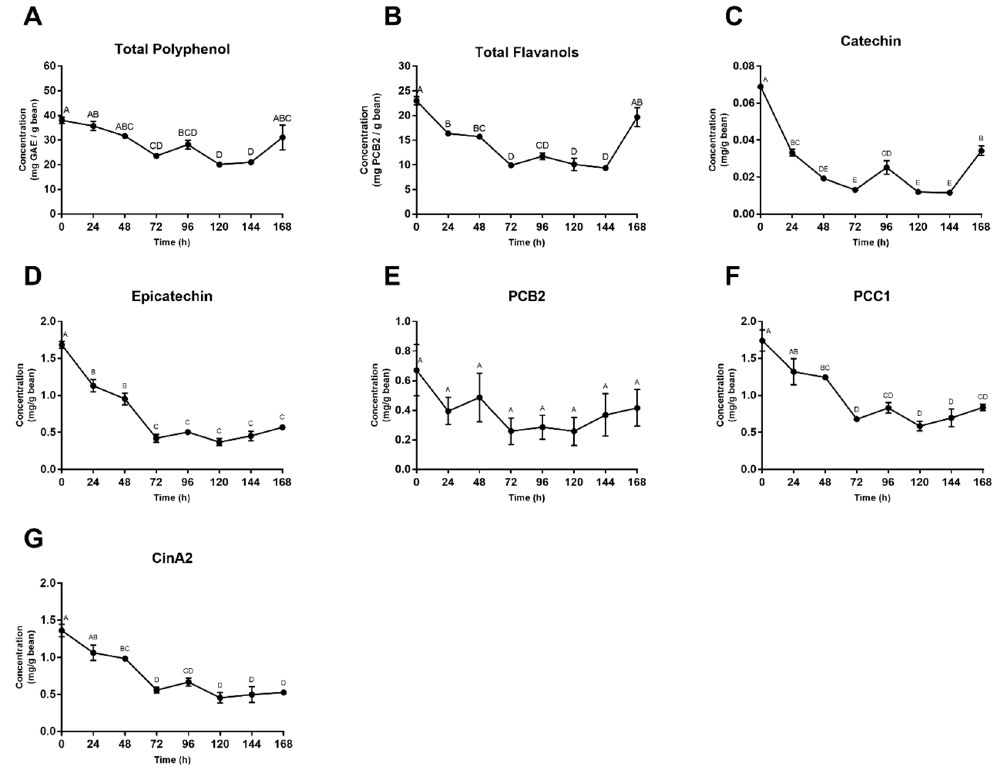
Figure 5. ( A ) Concentration of total polyphenols over the 168-h fermentation, as quantified by the Folin–Ciocalteu colorimetric assay, expressed in mg GAE/g cocoa bean. ( B ) Concentration of total flavanols over the 168-h fermentation, as quantified by the 4-dimethylaminocinnamaldehyde (DMAC) colorimetric assay, expressed in mg PCB2/g bean. ( C – G ) Individual polyphenol concentrations (C, EC, PCB2, PCC1, CinA2) over the 168-h fermentation, as quantified by reversed phase UPLC-MS, and expressed as mg/g cocoa bean. Values are presented as the mean ± SEM of fermentation replicates. Significance between time points was determined by one-way ANOVA and Tukey’s HSD post-hoc test ( p < 0.05). Time points with different letters are significantly different within values.